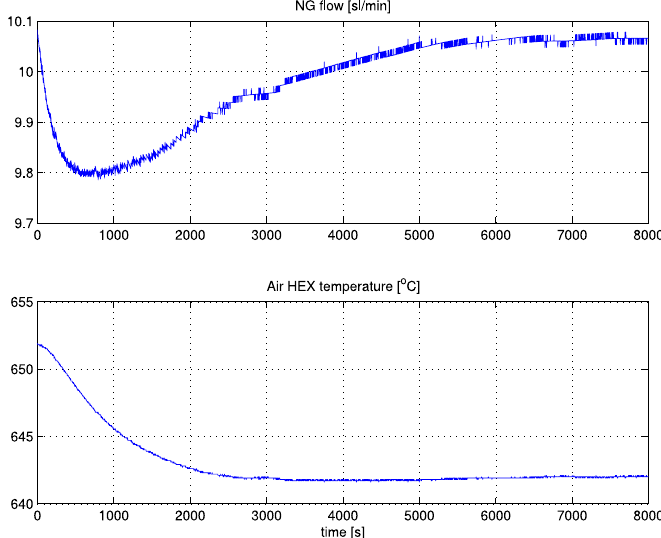
Figure 27. Closed-loop response of Air HEX control loop.